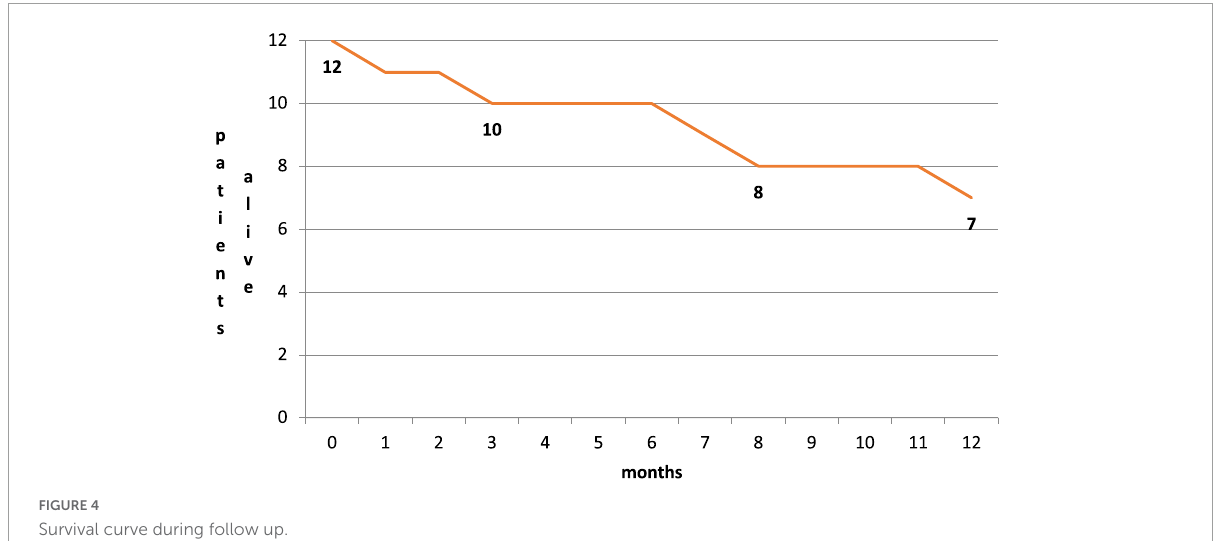
FIGURE4 Survival curve during follow